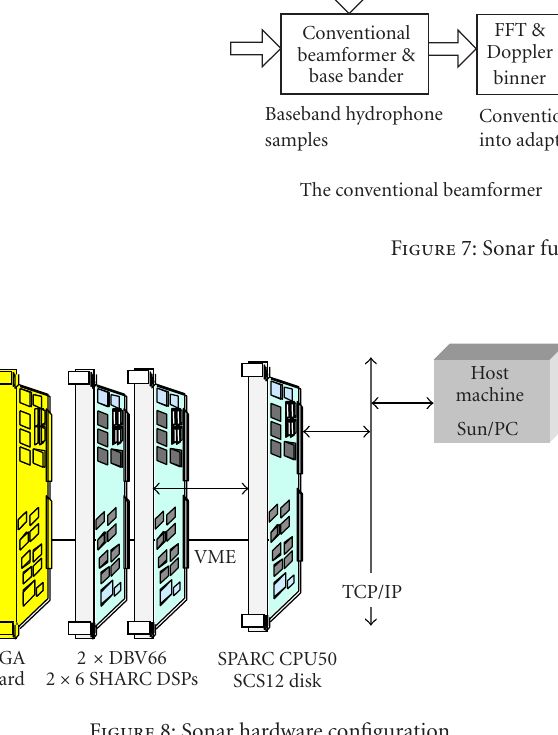
Figure 8: Sonar hardware